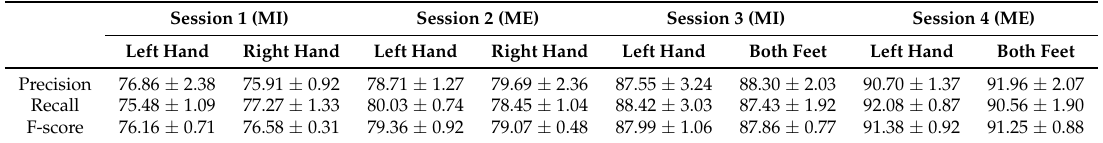
Table 3. The mean precision, recall and F-score of the different two classes of four sessions using S3 classification strategy in the decoder-training phase across all subjects (in